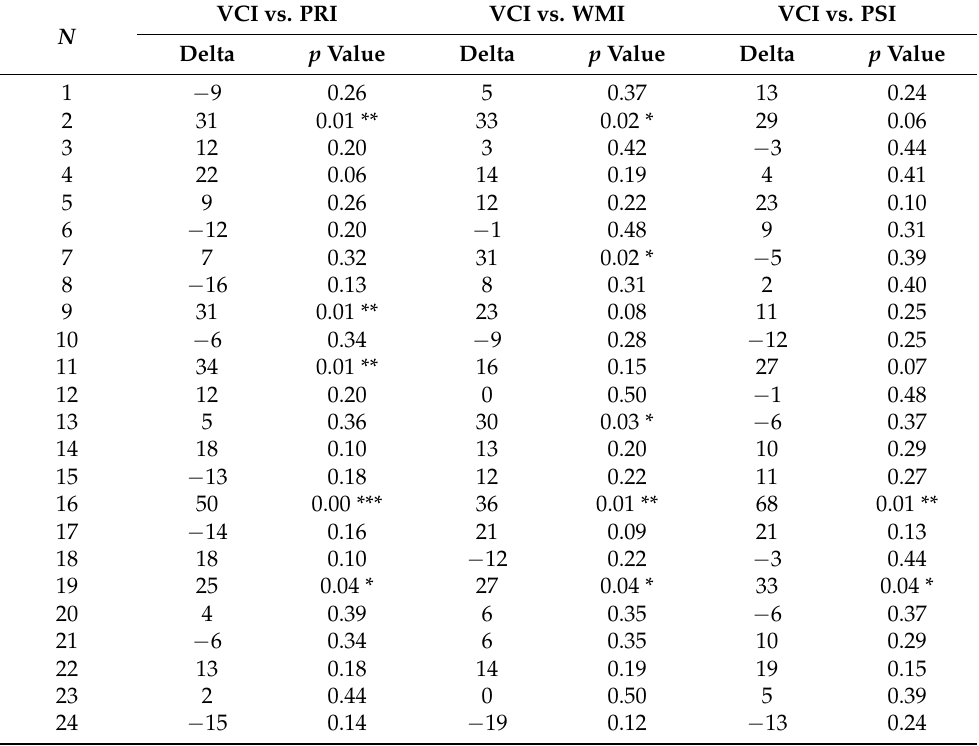
Table 5. Statistical differences between verbal comprehension index and the remaining indexes of Wechsler scales per each individual in our cohort compared to normative data of general population. VCI vs. N